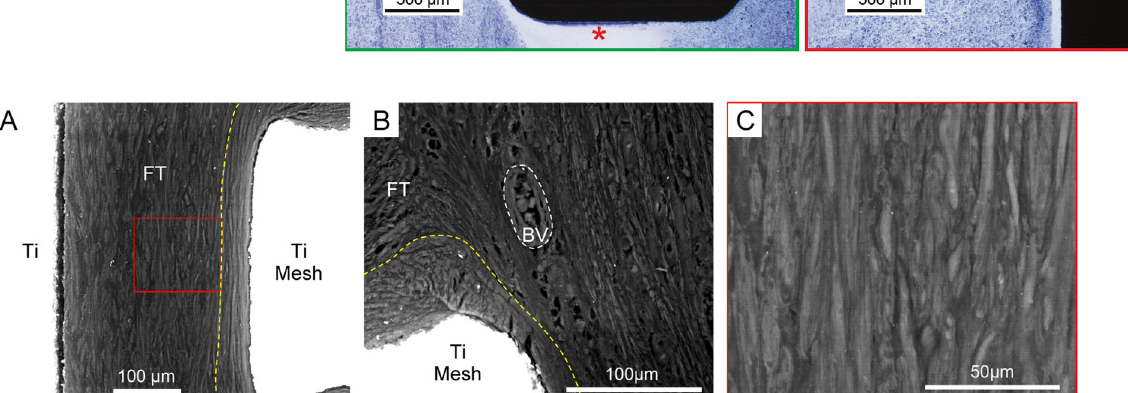
of the dense fi brous capsule intimately in contact with the mesh (Ti Mesh). B Peri-implant fi brous tissue (FT) delineating the mesentery and showing vascular supply (white-dotted line; BV: blood vessel) in close vicinity to the dense capsule (yellow-dotted line) around the mesh (Ti Mesh). C Magni fi ed area highlighting fi brous bundles with different orientations in tissues integrated with the inner cylinder shown in ( A ) (Red